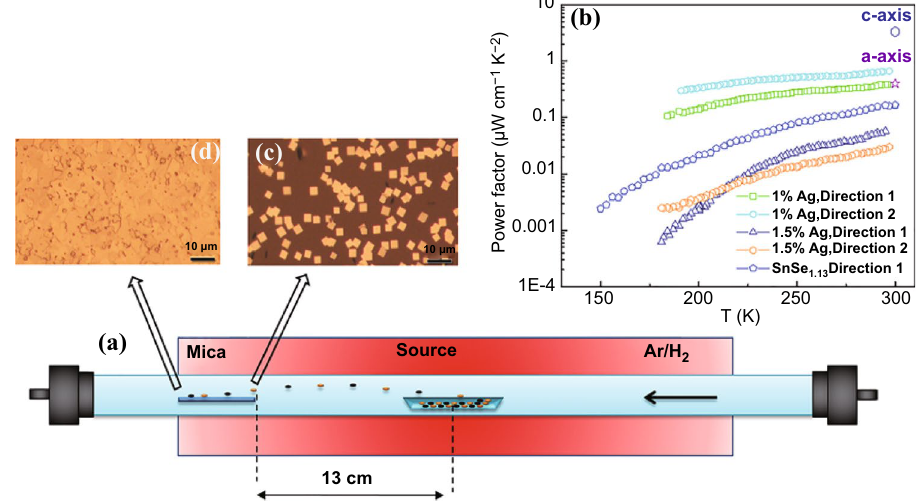
Fig. 12 a SnSe structure and CVD growth. b PF of SnSe and Ag doped SnSe nanoflakes. c SnSe nanoflakes grown in the high-temperature area on substrate. d nanostructured thin films formed in the low temperature area on substrate. Adapted with permission from Ref.